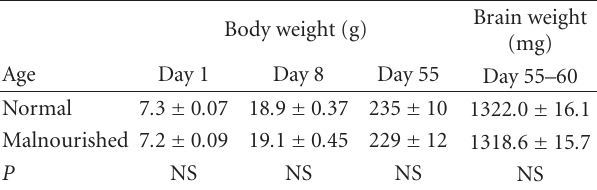
Table 1: Body and brain weights of normal and prenatally malnourished rats. Values are means ± SEM. N = 16 rats in each group. No statistically significant di ff erences (NS) were found when comparing body and brain weights of normal and malnourished groups of same ages (unpaired Student’s t -test).